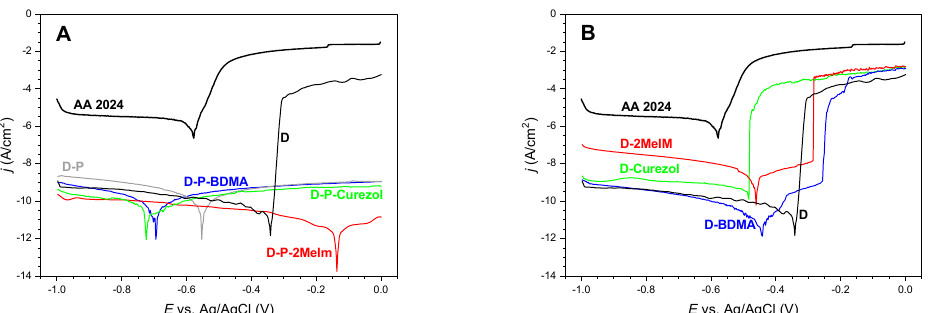
Figure 11. Potentiodynamic polarization curves of protective coatings; ( A ) D-P-based formulations and ( B ) D-based formulations.